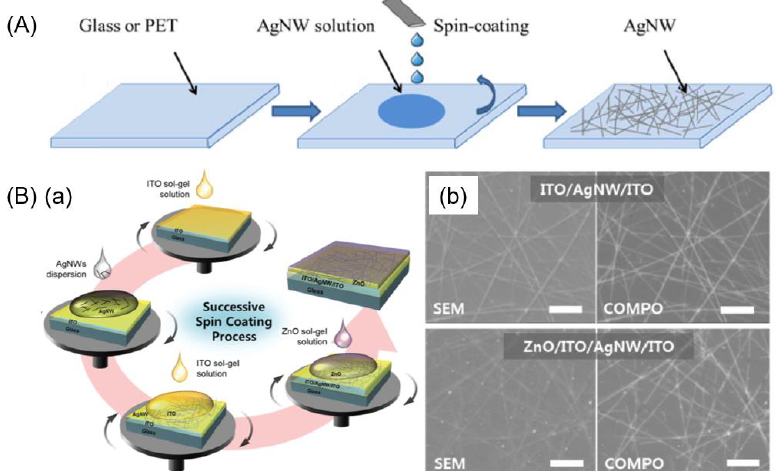
Figure 3. Scheme and electronic images of Ag NW networks prepared by spin coating. ( A ) Single deposition of Ag NW network. Reproduced with permission from [12]. Copyright 2018 Elsevier B.V. ( B ) Serial deposition to form a composite of Ag NW and ZnO: ( a ) Schematic illustrating successive spin-coating processes used to fabricate ZnO / ITO / Ag NW / ITO composite structure. ( b ) FE-SEM images of composite electrodes. Reproduced with permission from [13]. Copyright 2016 Royal Society of Chemistry.